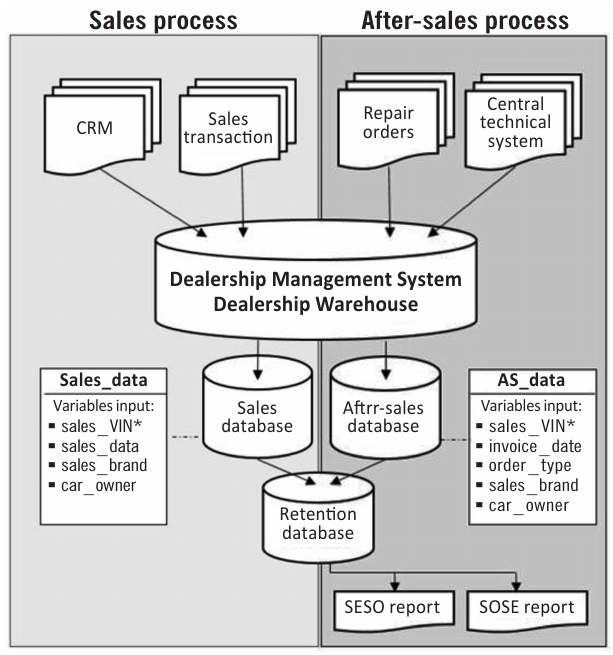
Figure 1. Data flow and characteristics in sales and aftersales service processes used in the design of SESO and SOSE